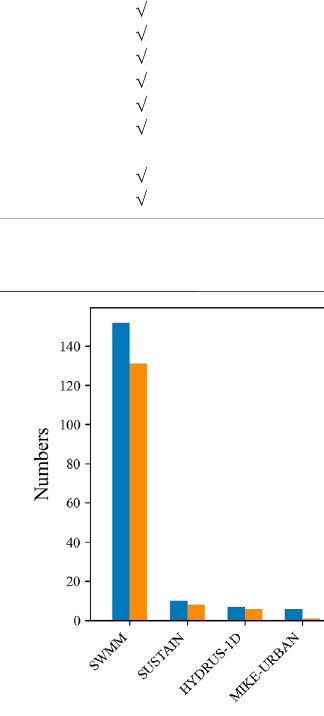
FIGURE 2 | Number of publications relating to Sponge City modelling between January 1st, 2000 and July 3rd,